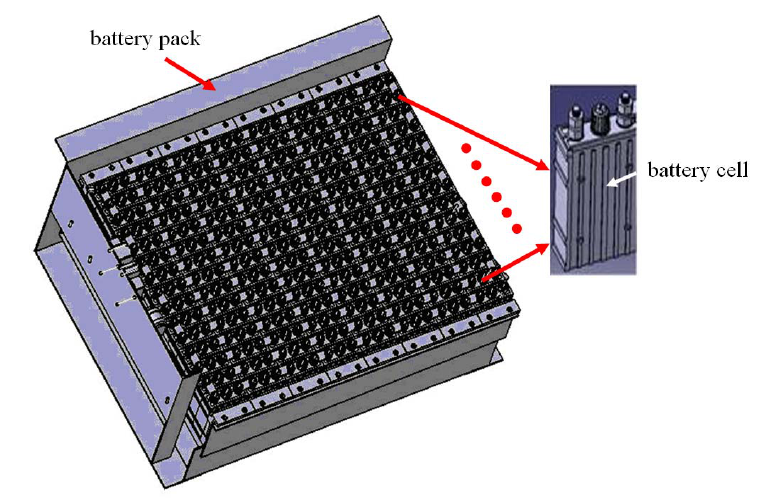
Figure 13. Improved battery pack structure.